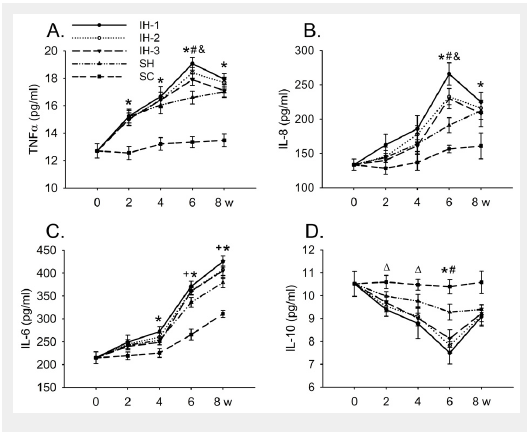
Arterial blood gas tension measured in the preliminary intermittent hypoxia experiment. Two rats were employed in each treatment group (n = 2); the measured parameters of each animal were plotted as separate bars. The minimum Po 2 levels of two animals (white and hatched bars respectively) in the IH1, IH2, and IH3 group and SH group were markedly reduced as compared to those shown in the normoxia control group. The maximum Pco 2 levels of the two rats (black and grey bars respectively) were comparable among all the treatment groups.